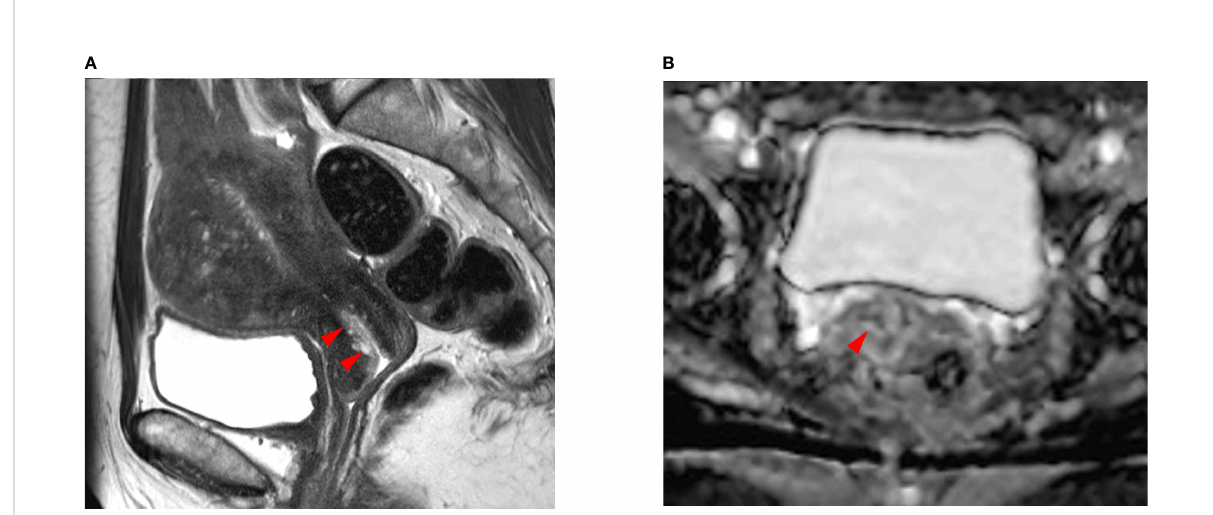
FIGURE 2 A 48-year-old woman with endocervical adenocarcinoma. (A) The T2-weighted sagittal MR image shows no tumor in the uterine cervix. The red arrows indicate a poorly demarcated cystic mass, which was preoperatively interpreted as normal endocervical glands. (B) The apparent diffusion coef fi cient (ADC) axial image shows no focal lesion with low ADC values in the cervical canal (red arrowhead). However, the pathologic report con fi rmed that there was a residual tumor in the endocervical canal. The tumor size was measured as 2.0 × 1.5 cm and the depth of stromal invasion was 0.4 cm in a 1.3-cm cervical wall. It was well-correlated with the endocervical lesion in (A) . Tumor invasion to the lymphovascular space, vagina, and parametrium and lymph node metastasis were all